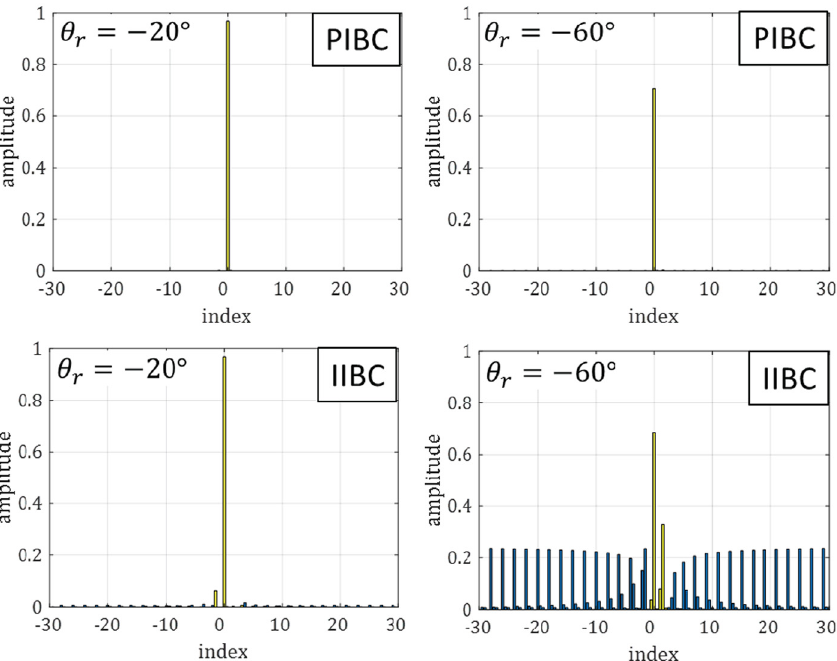
Fig. 5. Amplitude of the Floquet wave spectrum of the re fl ected electric fi eld for: (top) the PIBC solution in (5) and (bottom) the PIBC obtained by removing from the IIBC in (4) the contribution of the grounded slab evaluated at the incidence wavenumber. The amplitude of the FWs is shown for an TE-polarized incident wave at u i ¼ 0 ° and a TM-polarized re fl ected wave of u r ¼ (cid:3) 20 ° and u ¼ (cid:3) 60 ° , with a permittivity of the dielectric of e ¼ 2 : 5 r r